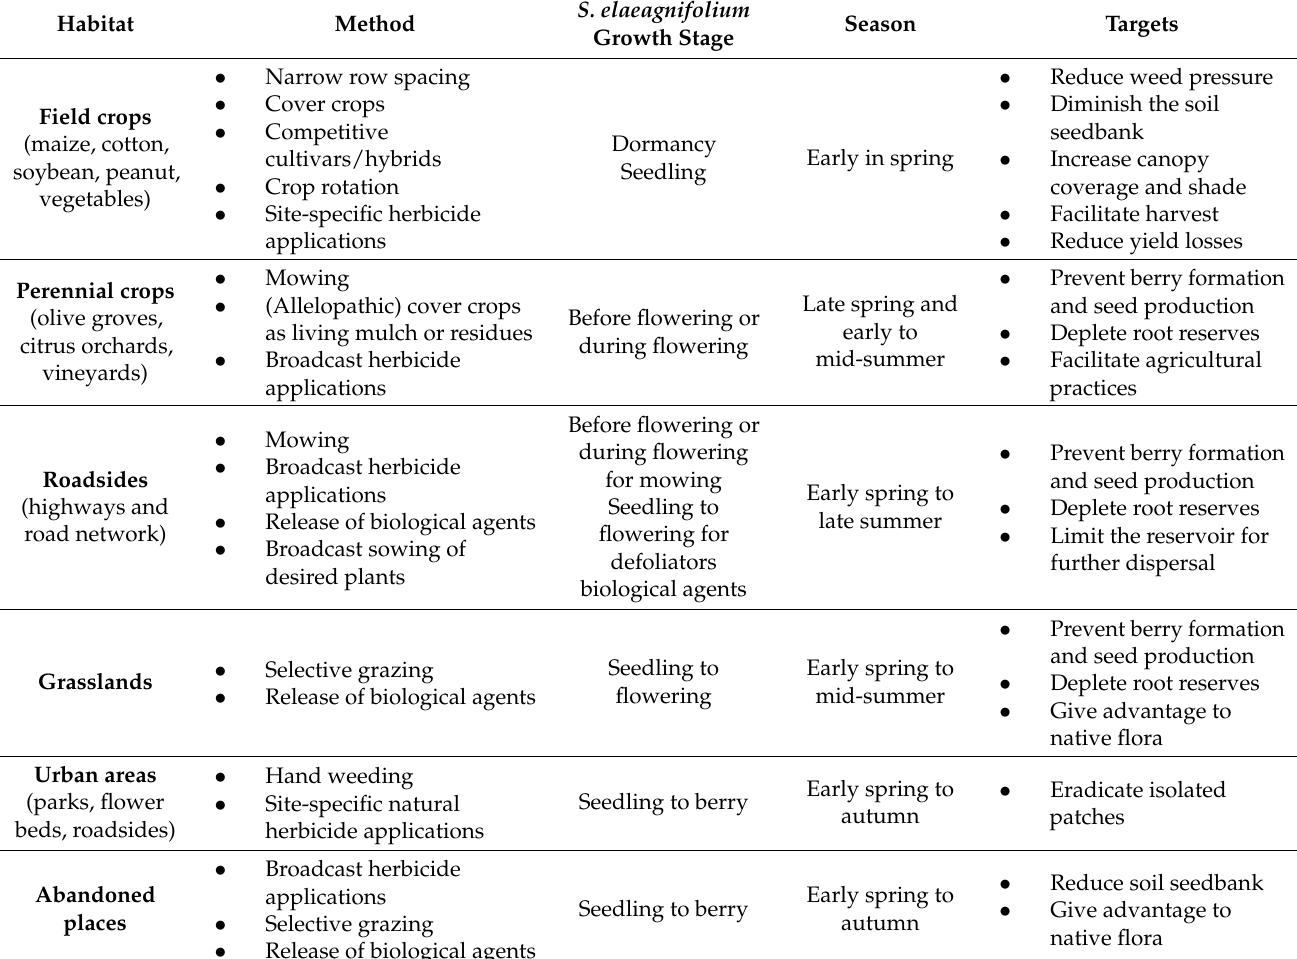
Table 1. Recommended methods for the management of Solanum elaeagnifolium in different